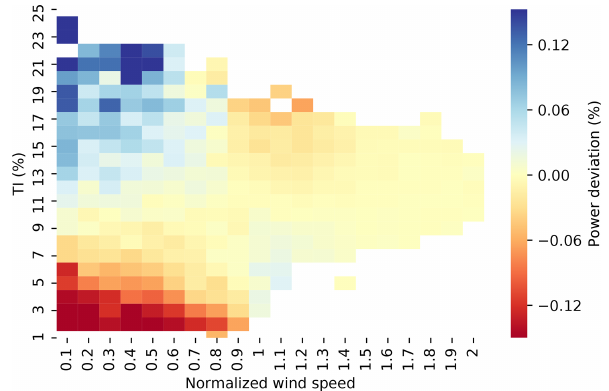
Figure 1. A typical power deviation matrix (PDM) between nor- malized wind speed and turbulence intensity (TI). The predicted power subtracted from the observed power yields the power devi- ation in the inner range, i.e., power deviation = observed power – reference power (or predicted power). A positive power deviation, seen in the blue region of low wind speeds and high TI, means larger observed power output than predicted power output, and vice versa for the red-colored cells. Zero normalized wind speed indicates the cut-in wind speed, and the normalized wind speed of one approxi- mately equals the rated wind speed. This particular PDM is derived and composited using 16 data sets supplied by a contributing mem- ber of the Power Curve Working Group (PCWG), and the data sets constitute part of the data submissions in this